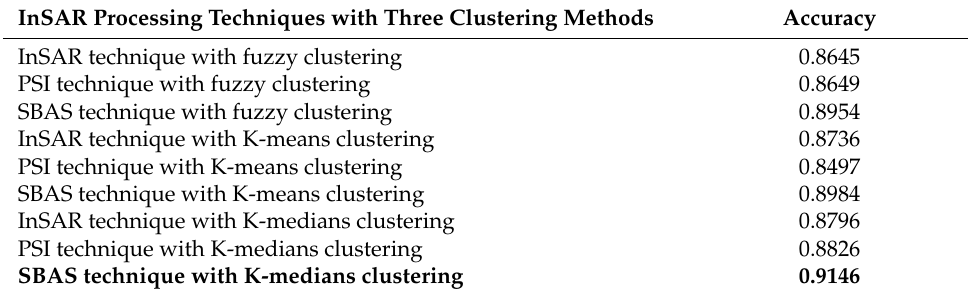
Table 4. The accuracy measures for each cluster are based on similarity